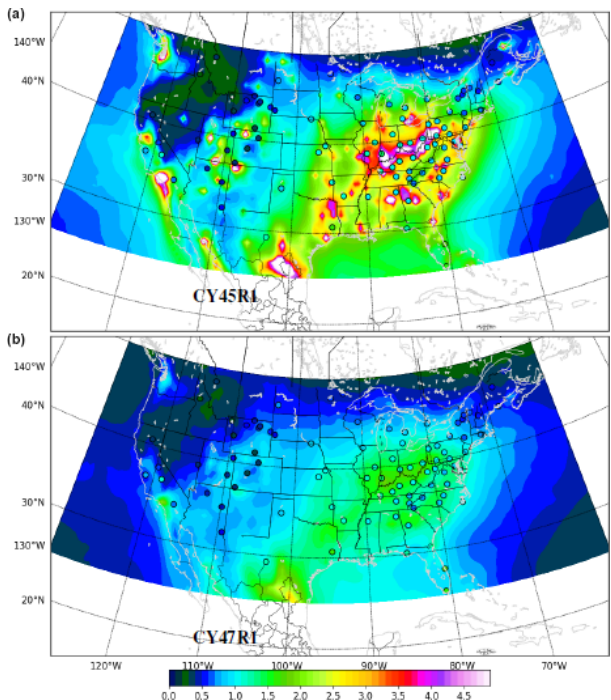
Figure 15. Mean 2017 surface sulfate concentration (in µgm − 3 ) simulated by CY45R1 (a) and CY47R1 (b) against the yearly aver- age of the CASTNET network (shown as black